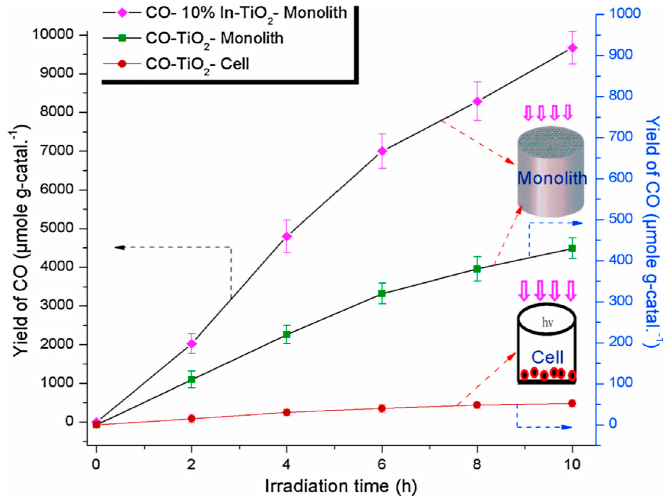
Figure 7. Illustration for comparison of TiO 2 coated on monolith and cell type support, reproduced with permission from reference [6]. Copyright Elsevier, 2013.